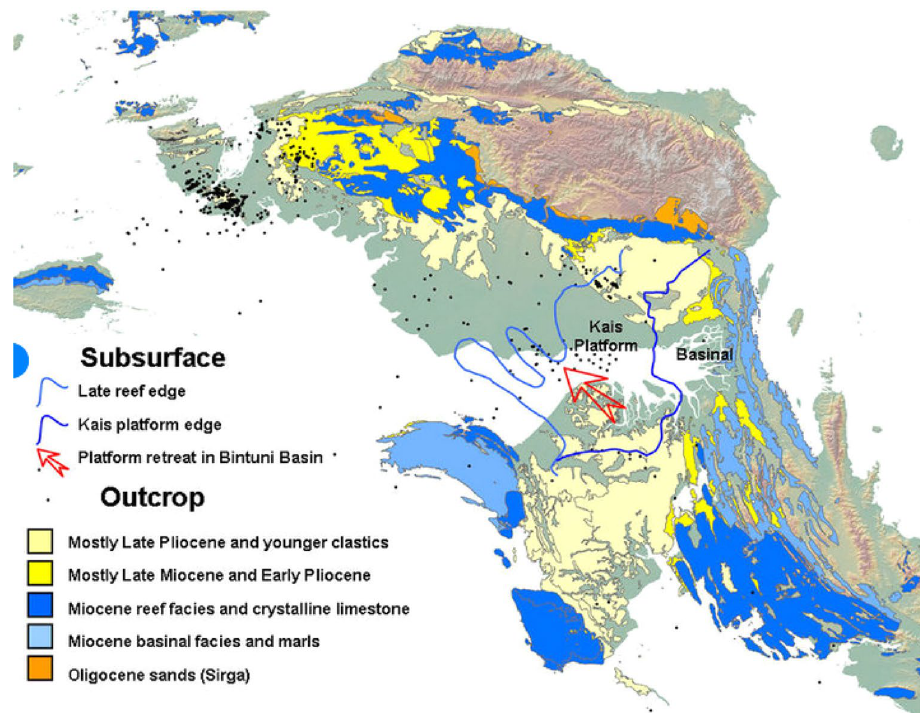
Fig. 5 Location of Bintuni basin (Adapted from Decker et al. 2011)